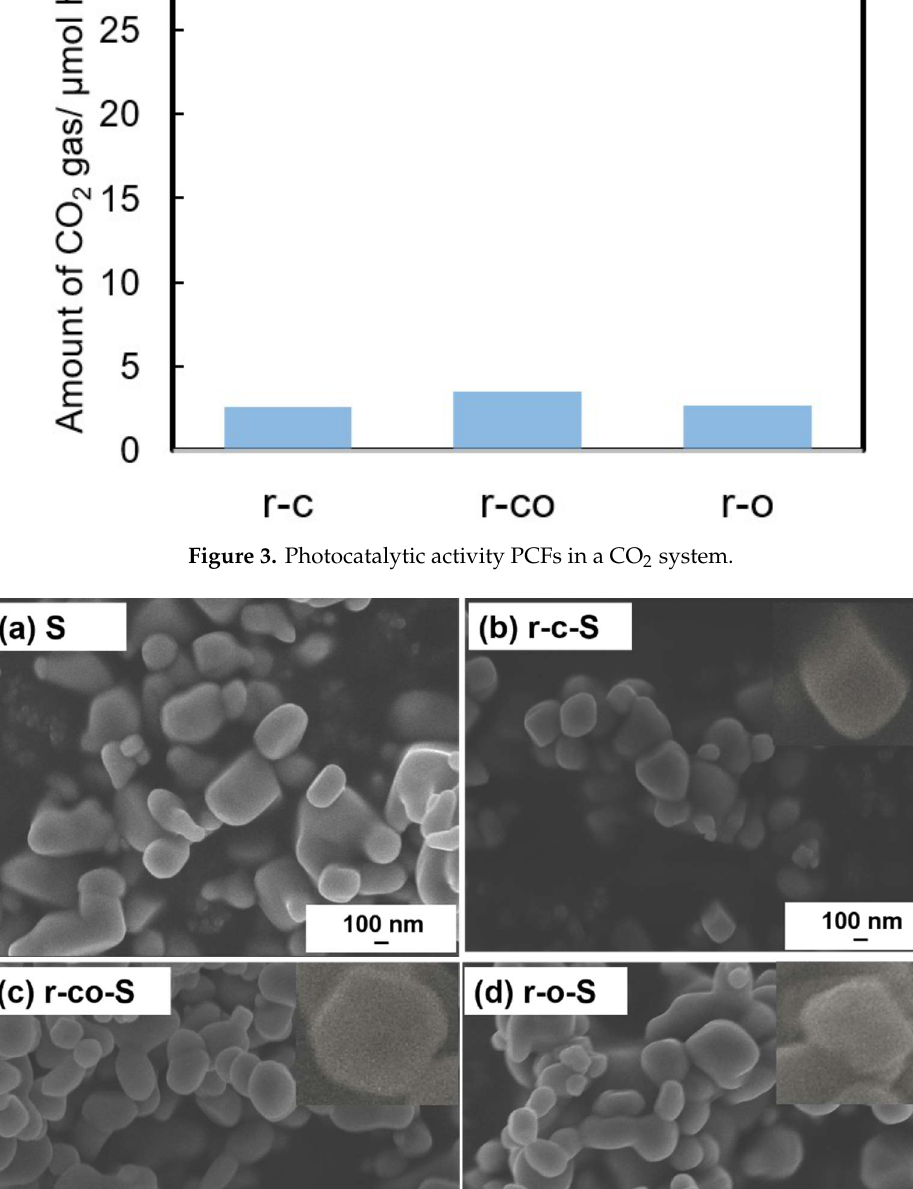
Figure 5. XRD patterns of titania (ST-G2) and FCP-loaded titania. ( a ) is the zoomed-in XRD patterns between 25° to 45°, ( b ) are the {110}, {101} and {211} planes of rutile titania, respectively.